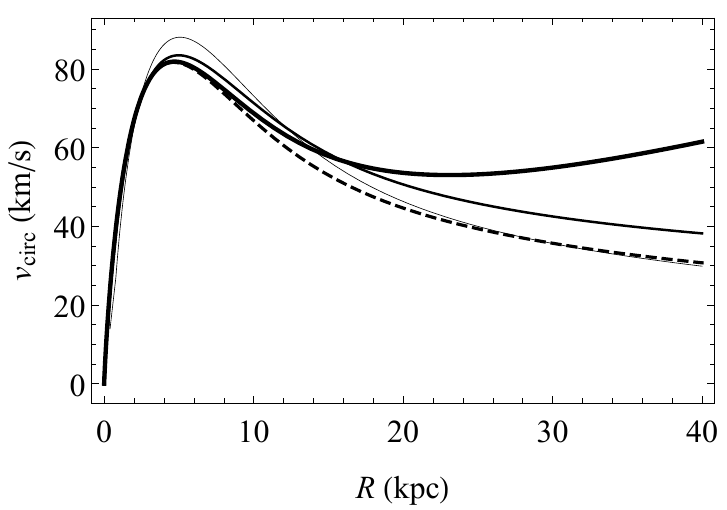
Figure 3 . Rotation curve of baryonic matter in the thin-disk approximation and an exponential matter density profile in Einstein’s theory (eq. (A.34), dashed curve) and in the multi-fractional theory T with weighted derivatives in the limit of small corrections (eqs. (4.51) and (4.46), where v α > 1 and R (cid:28) R ∗ ) for α = 1 . 1 , α = 4 / 3 and α = 1 . 9 (solid curves of increasing thickness). Here M = 1 . 72 × 10 40 kg , R 0 = 2 . 16 kpc and R ∗ = 40 kpc